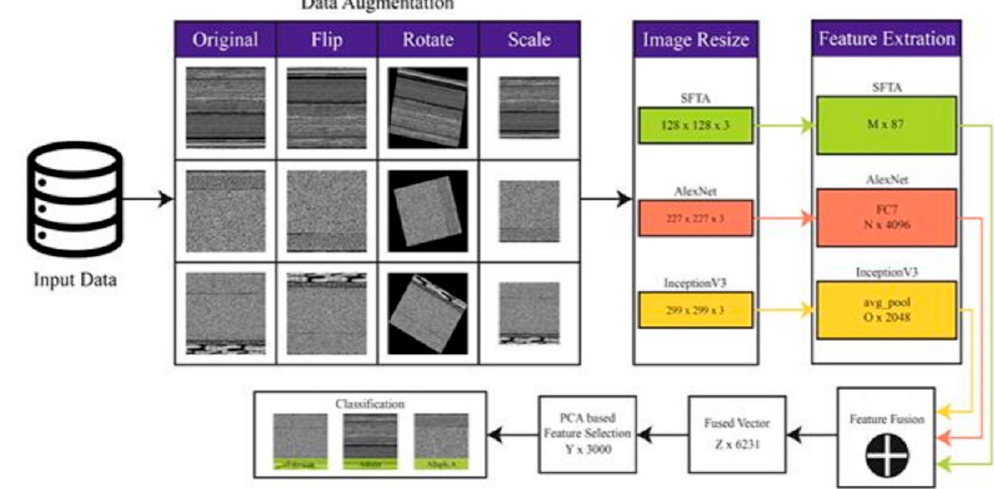
Figure 1. Flow diagram of the proposed malware classification method.